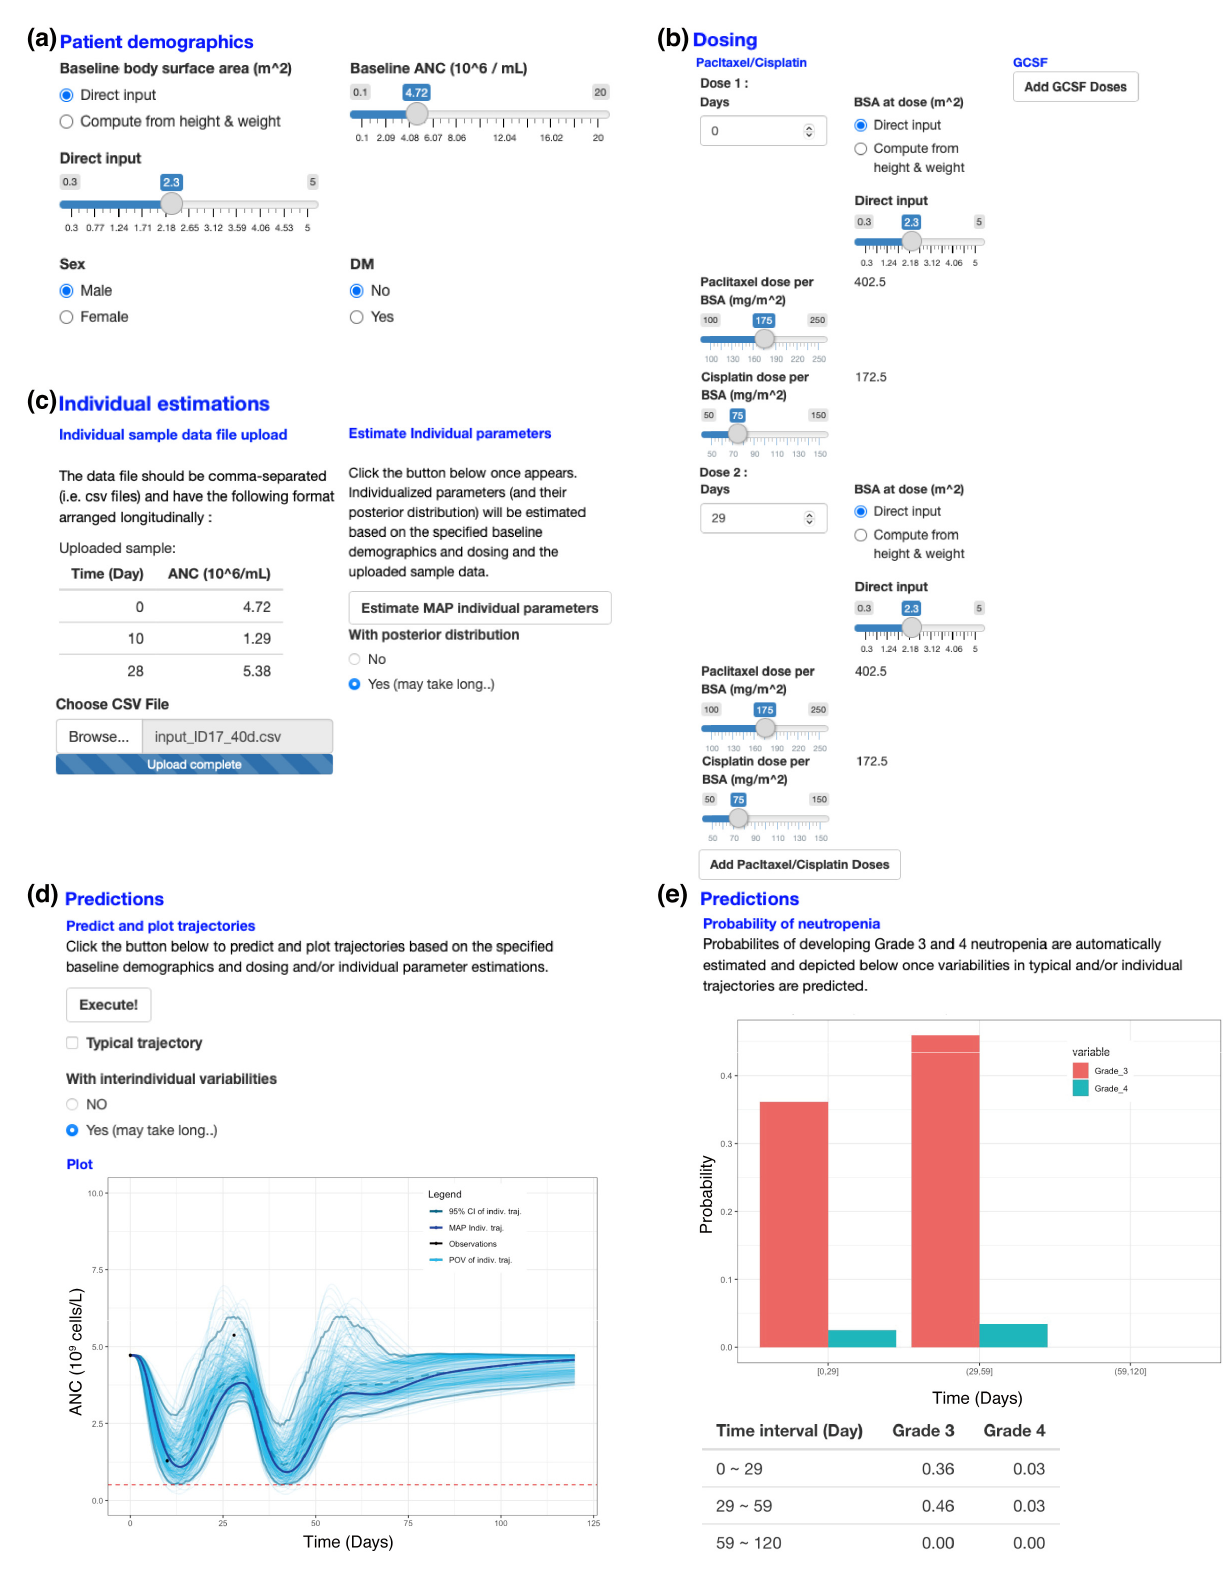
Figure 5. An illustrative example of the Shiny application. ( a ) Patient demographics. ( b ) Dosing schedule specification. ( c ) User input of observed ANC and individual estimation of parameters with their posterior distributions. ( d ) Simulation based on the estimated parameters and posterior distributions. ( e ) Assessment of the probability of grade 4 neutropenia.